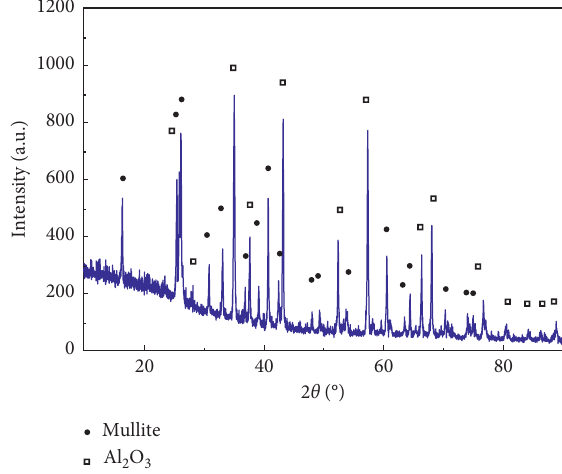
Figure 5: XRD patterns of sintered sample.